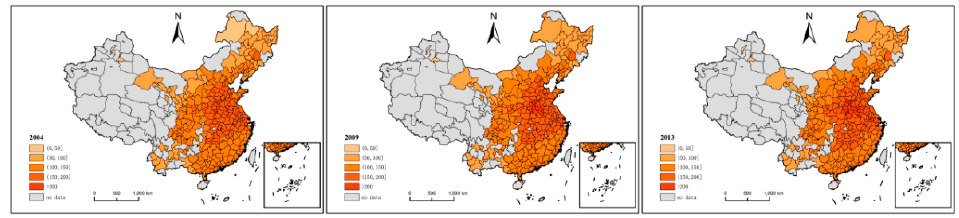
Figure 2. Spatiotemporal distribution of borrowing population.